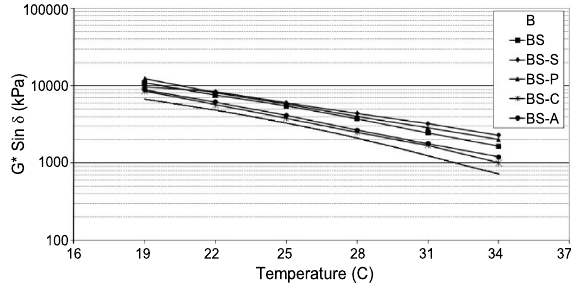
Fig. 9. Plot of tan δ against temperature for study binders at constant frequency of 1.59